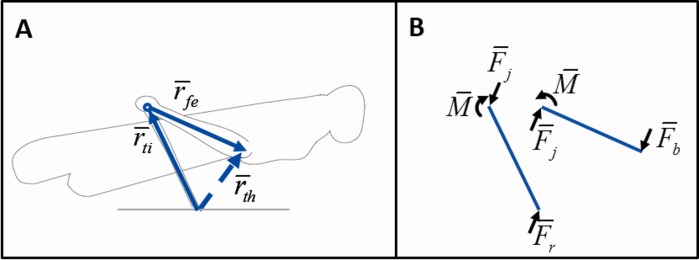
The locust hind leg model.(A) Model representation of the locust hind legs. (B) Free body diagram of the hind leg.